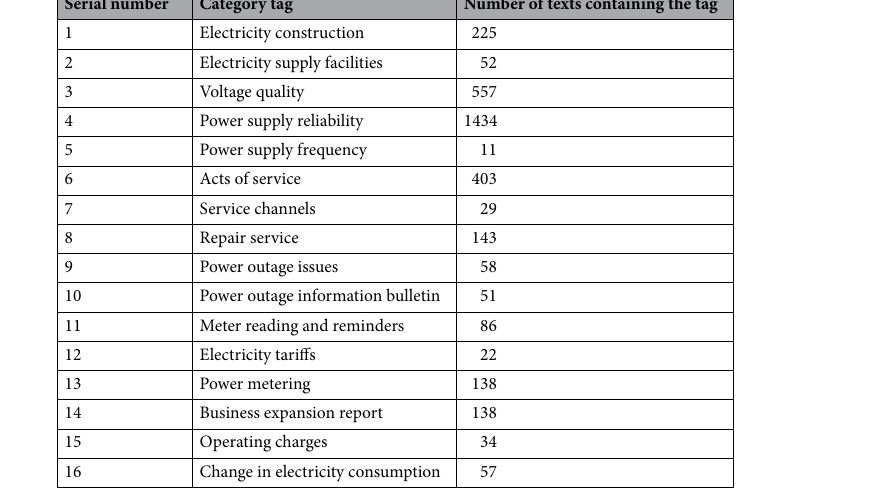
Table 1. Distribution of the samples in the secondary categories.